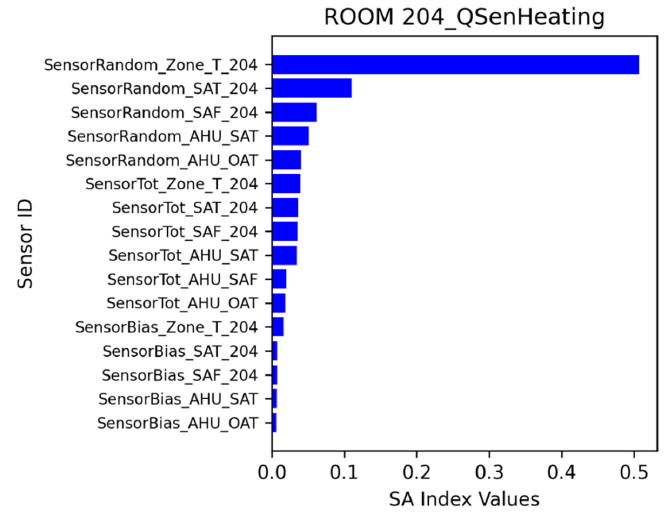
Figure 21. SA for zone 204 sensible heating.